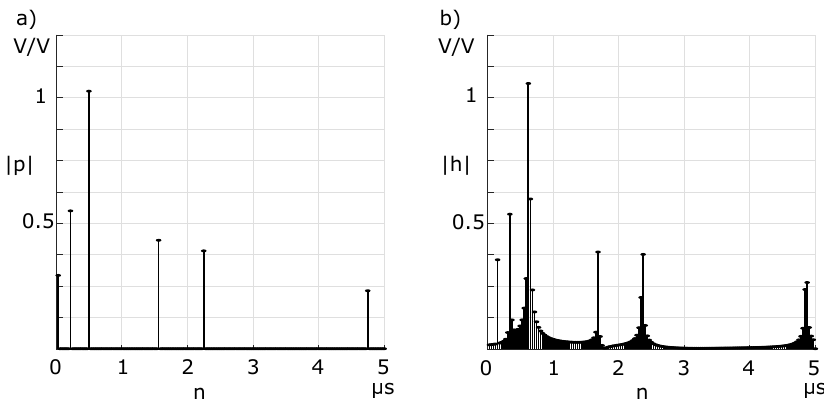
Figure 1. Comparison between ( a ) sparse and ( b ) compressible channel impulse responses.